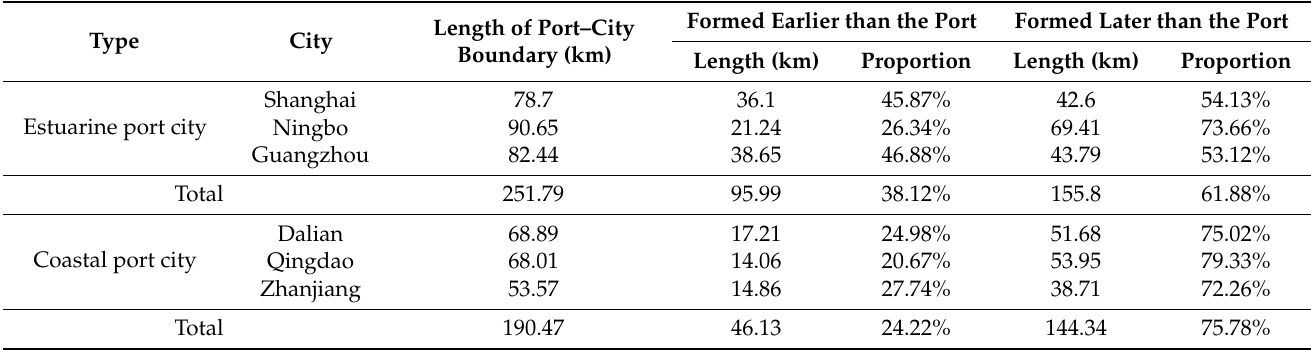
Table 2. Patch length of built-up area formed earlier/later than the port on the port–city